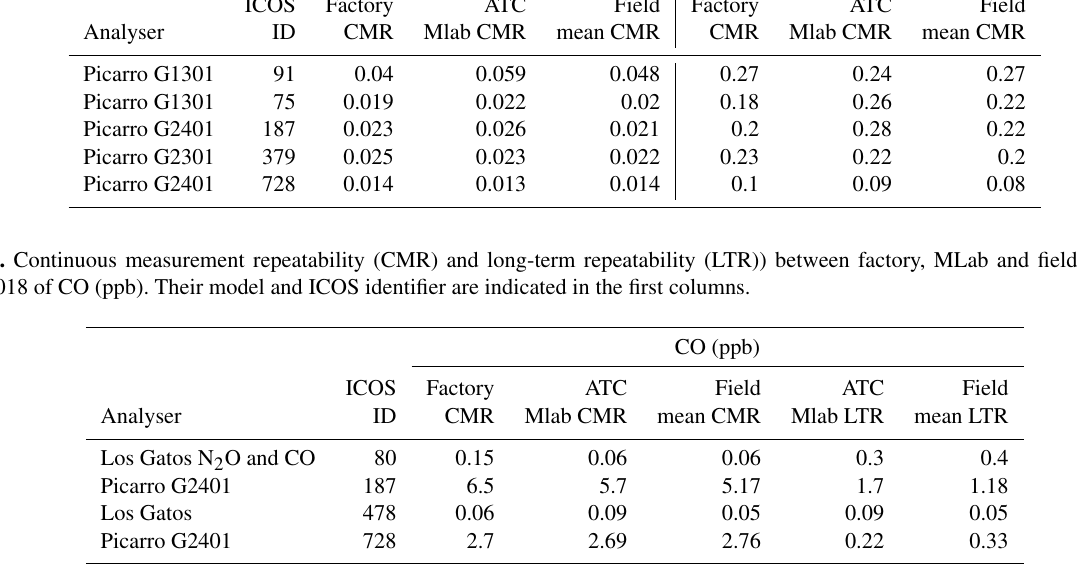
Table 4. Continuous measurement repeatability (CMR) estimated by the factory, MLab and field means over 2011–2018 for CO 2 (ppm) and CH 4 (ppb). Instrument model and ICOS identifier are indicated in the first columns. CO 2 (ppm) CH 4 (ppb) Factory ATC ATC ID CMR Mlab CMR